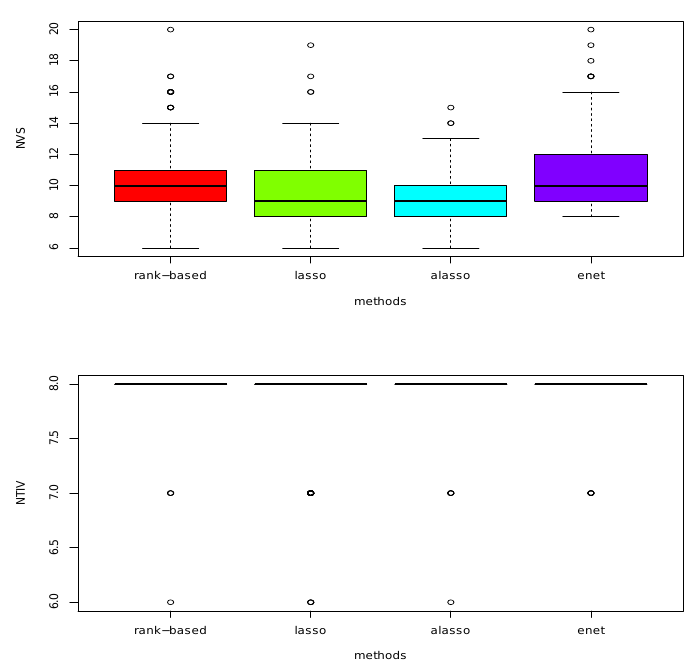
Figure 2. Boxplots of total number of variables (NVS) selected and the number of true important variables (NTIV) within the number of variables selected with four different models under scenario 1 based on 200